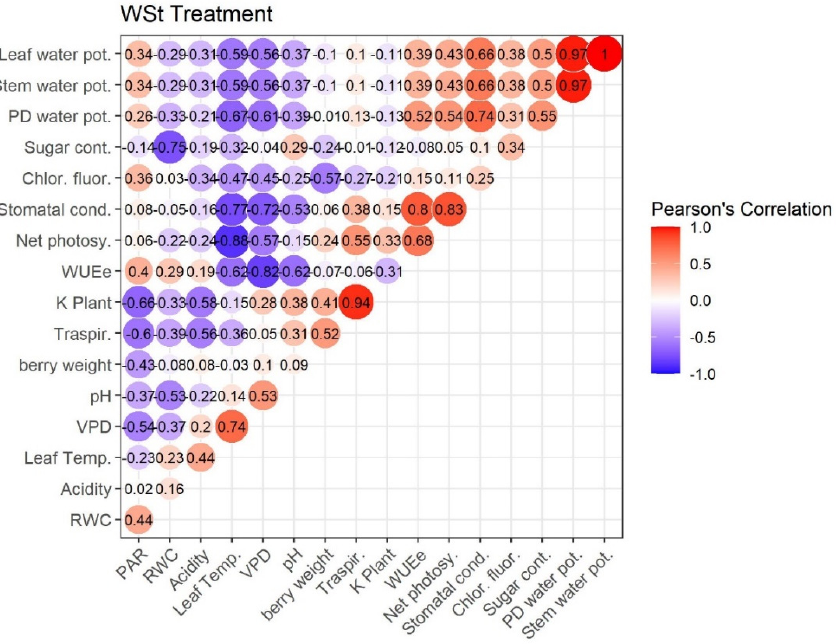
Figure 9. Pearson’s Correlation. WSt Treatment (Water stress + Zeolite). Ecophysiological and technological correlations between the pairs of traits were analyzed. Correlations were calculated from the mean values of each of the four treatments characterized. Positive correlations are displayed in red and negative correlations in violet. The color intensity and the size of the circle are proportional to the correlation coefficients. The grey background boxes illustrate the significant values at the level of p < 0.05 (two-tailed).